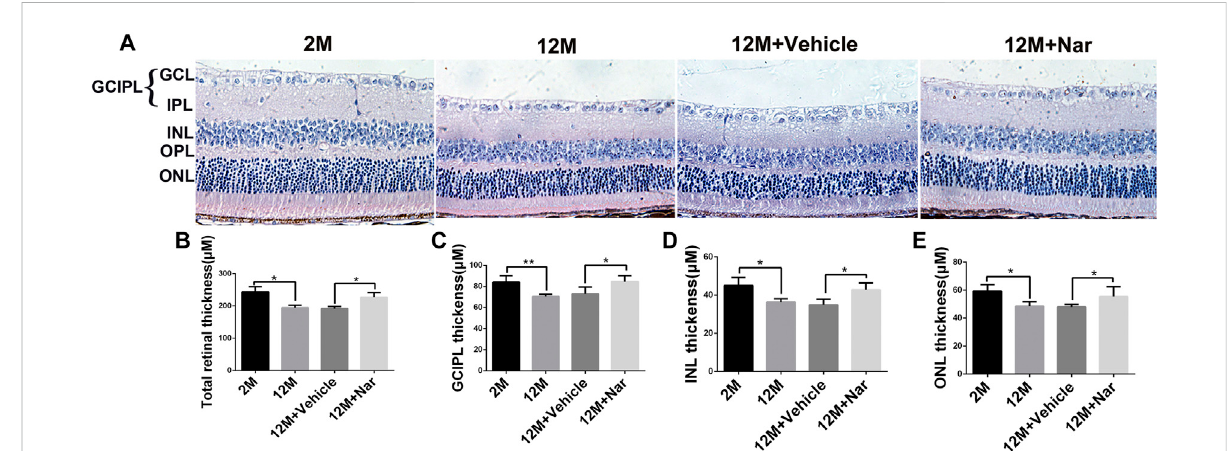
FIGURE 2 Naringenin prevented aging-induced retinal degeneration. (A) Hematoxylin and eosin staining was observed using an inverted fl uorescence microscope from 2 M, 12 M, 12 M+ Vehicle, and 12 M + Naringenin. Magni fi cation 40×. (B) The retinal thickness of thetotal retina. (C) The thickness ofthe GCIPL. (D) The thickness of theINL. (E) The thickness oftheONL. GCIPL, ganglion cell and inner plexiform layer;INL, inner nuclear layer;OPL, outer plexiform layer; ONL, outer nuclear layer. The results are expressed as the mean values ± SEM, n = 5. One-way ANOVA, post hoc Tukey ’ s test (* p < 0.05, ** p <